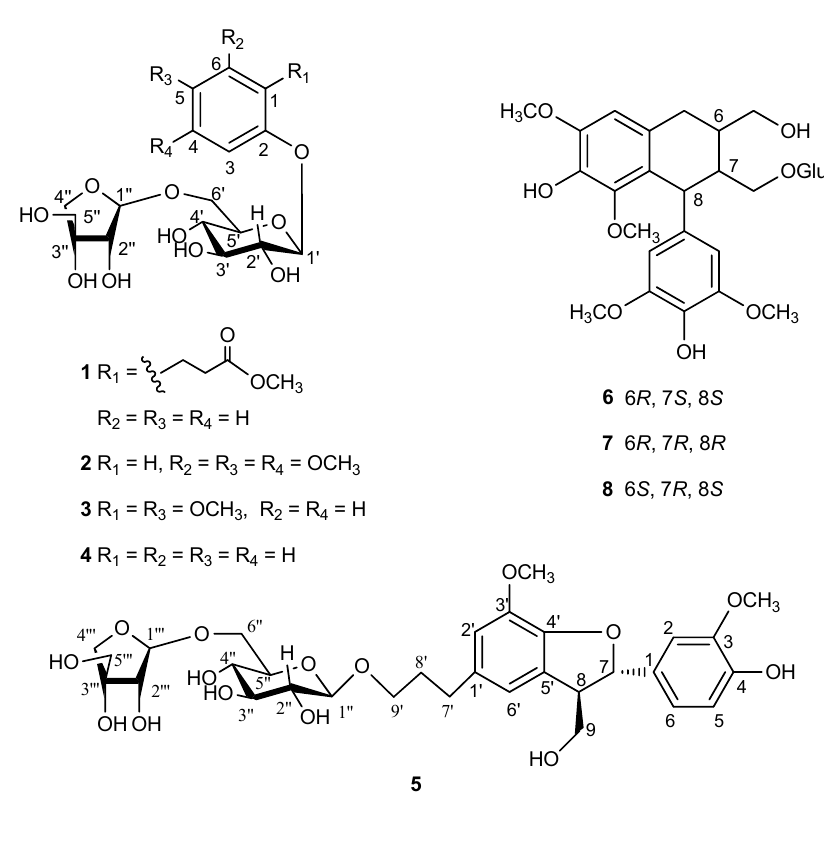
Figure 1. Structures of 1 – 8